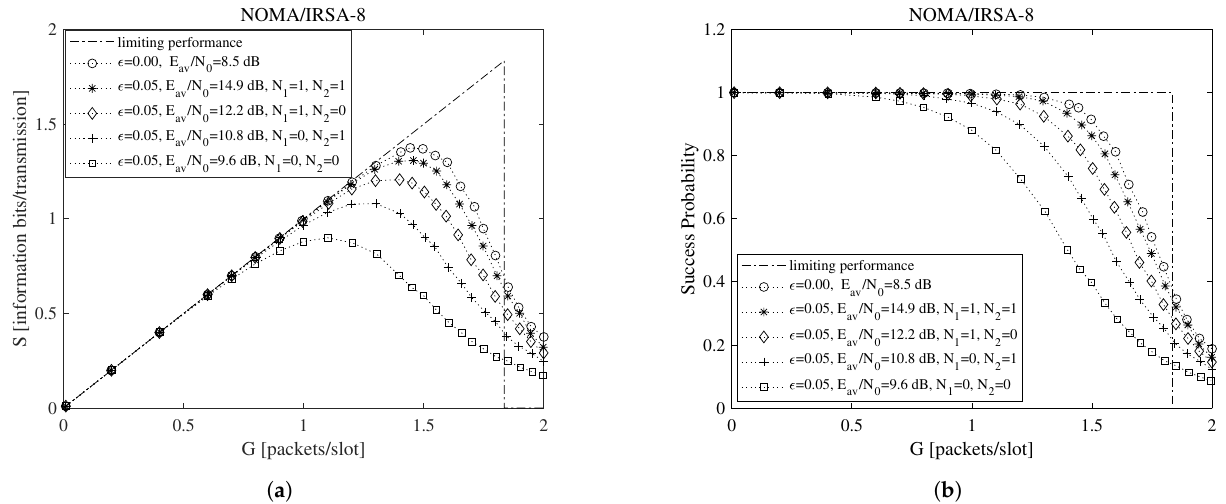
Figure 3. Performance as a function of the channel load for NOMA/IRSA-8 with K = 100, L = 3, and R = 1 information bits per symbol: ( a ) throughput, ( b ) success